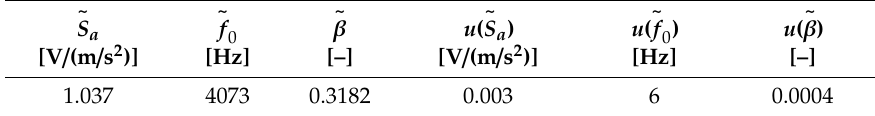
Table 2. Estimated parameters and associated uncertainties obtained by using the weighted least squares procedure (WLSP).